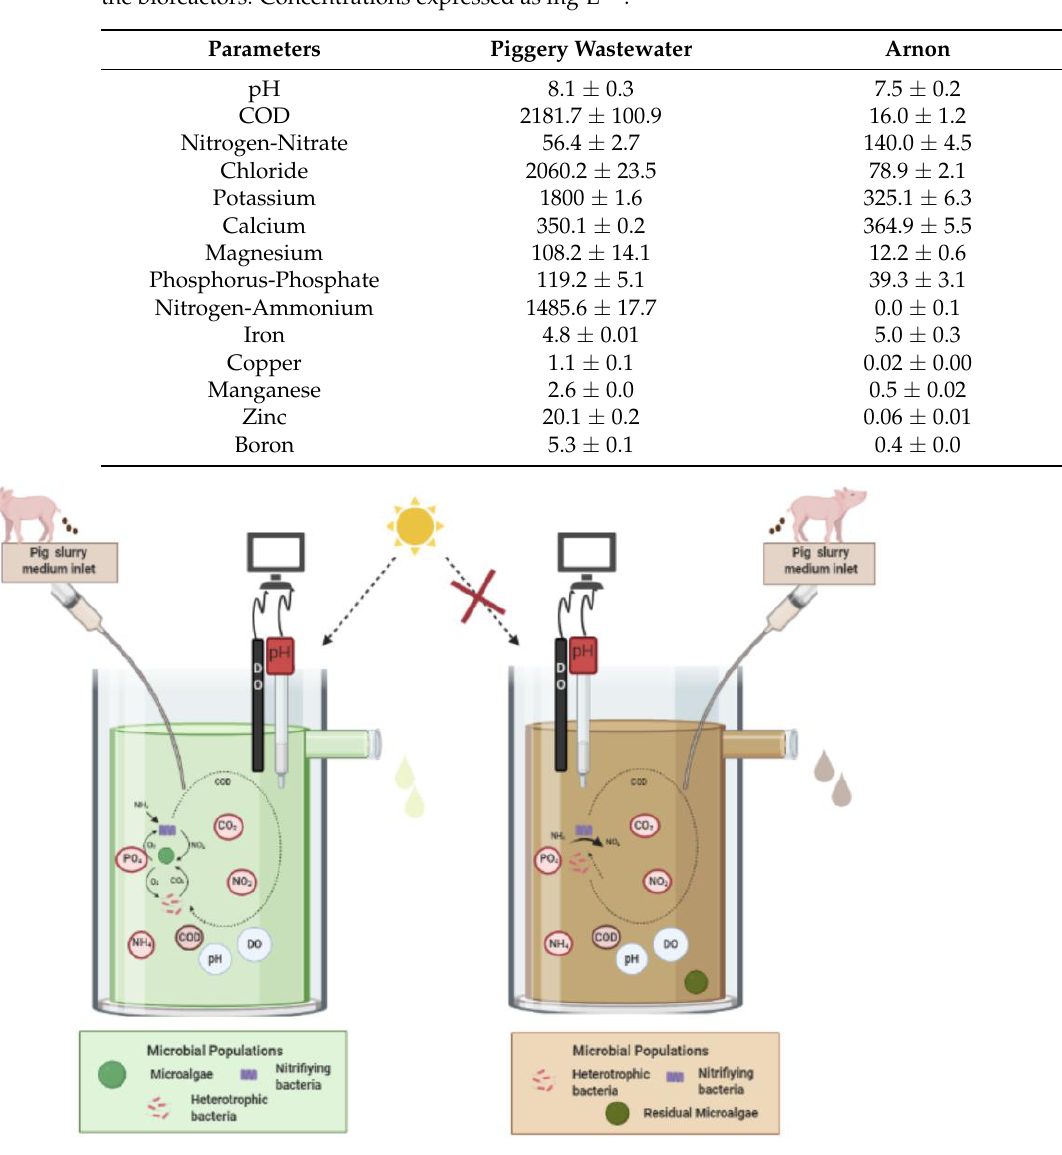
Figure 1. Graphical description of the experiments performed under light and dark conditions.